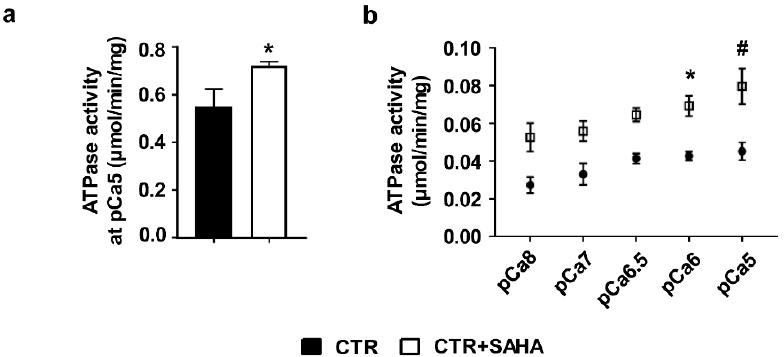
Figure 2. Effect of SAHA treatment on SERCA2 ATPase activity evaluated in cardiomyocytes isolated from adult rat hearts and HL-1 cells. ( a ) ATPase activity assay performed on microsomes isolated from adult rat CMs either untreated or treated with SAHA at pCa5. Experiments were performed on 3 independent CM sets per group and repeated twice. Unpaired Student’s t -test: * p < 0.005 vs. CTR; ( b ) ATPase activity assay performed on microsomes isolated from HL-1 cells at different pCa. Each point represents the mean ± SEM of at least 4 independent experiments; Two-way ANOVA followed by Sidak’s multiple comparison: * p < 0.05 vs. SAHA pCa6; # p < 0.05 vs. SAHA pCa5. All data are presented as mean ± SEM.